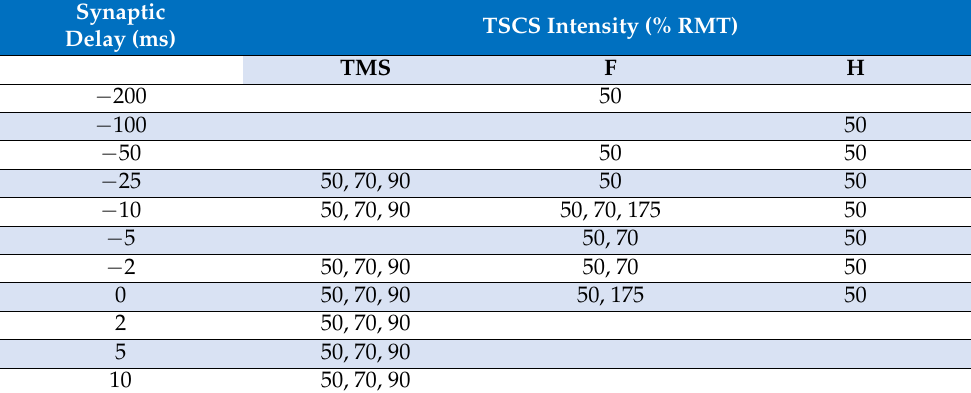
Table 1. Scheme for conditioning experiments. Conditioning TSCS pulses were delivered at the indicated intensities (in % of TSCS resting motor threshold) at various synaptic delays relative to test pulses (TMS, F-wave, or H-reflex). Synaptic delay represents the time of TSCS pulse arrival at cervical motor neurons relative to test pulse arrival. Negative numbers indicate TSCS pulse arrival before test pulse